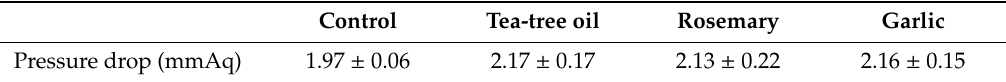
Table 3. Pressure drop of the control and plant extract-coated air